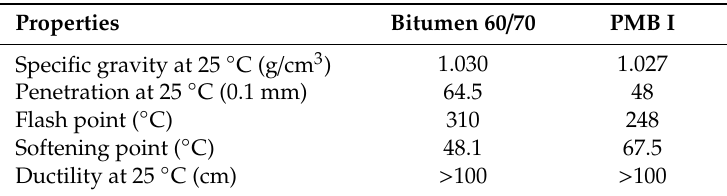
Table 2. Physical properties of Bitumen 60 / 70 and PMB I bitumen.